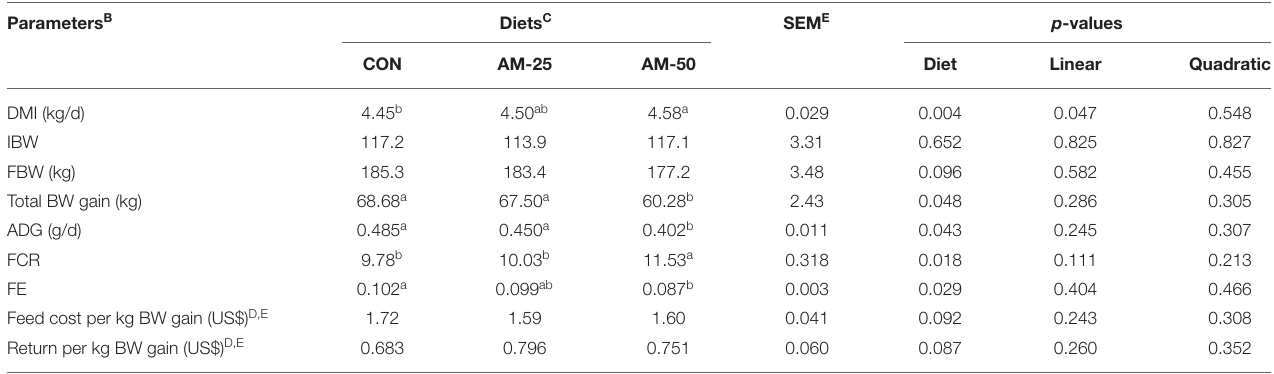
TABLE 2 | DM intake, growth performance, and feeding cost of growing camels fed experimental diets A . Parameters B Diets C SEM E p -values AM-25 AM-50 Diet Linear